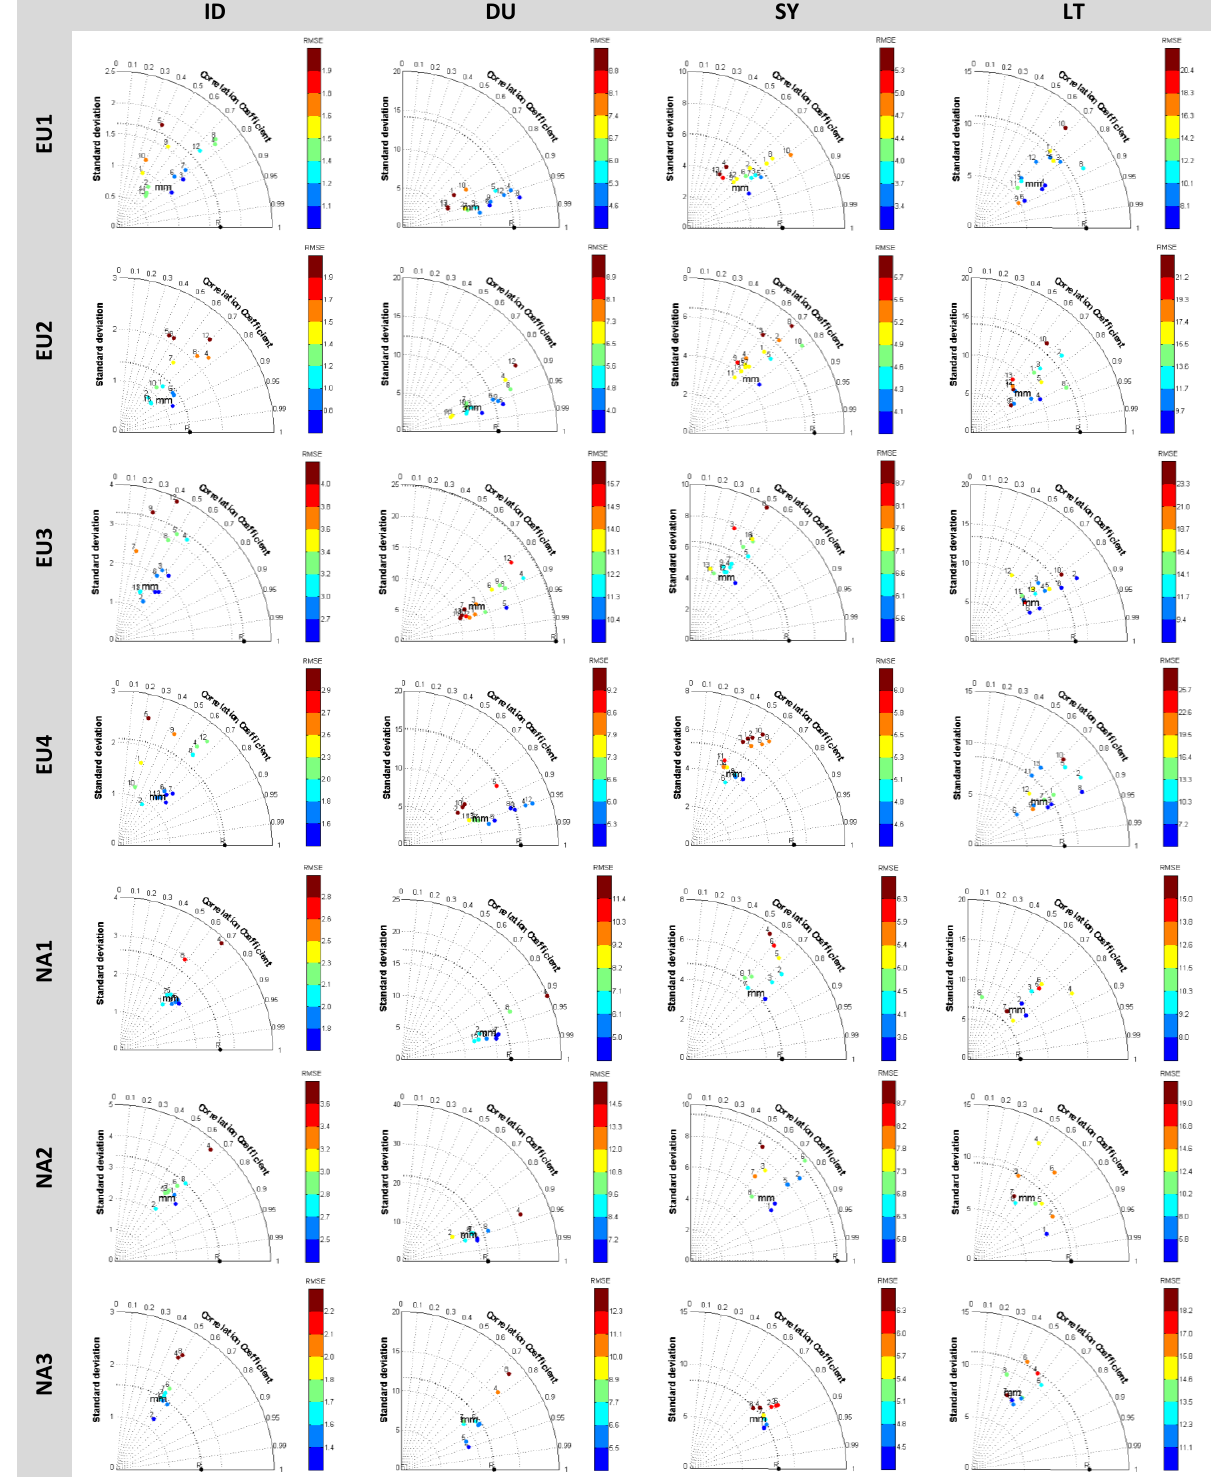
Fig. 7f. Properties of the spectrally decomposed modelled time-series of ozone, into four (ID, DU, SY, LT) components, versus their observed counterparts. Results are shown for all seven subdomains and three ozone aggregation types. For all plots, the square marker reflects the mm, the filled square the kz, the red circle the observations and the coloured lines the individual models. (f) Taylor diagrams of the modelled ID, DU, SY, LT spectral components (rural stations). Modelled ID is less successful in capturing the pattern (correlation), followed by SY. The amplitude (variance ratio, error) is generally conceived by the spectral components, with regional variability of the modelled